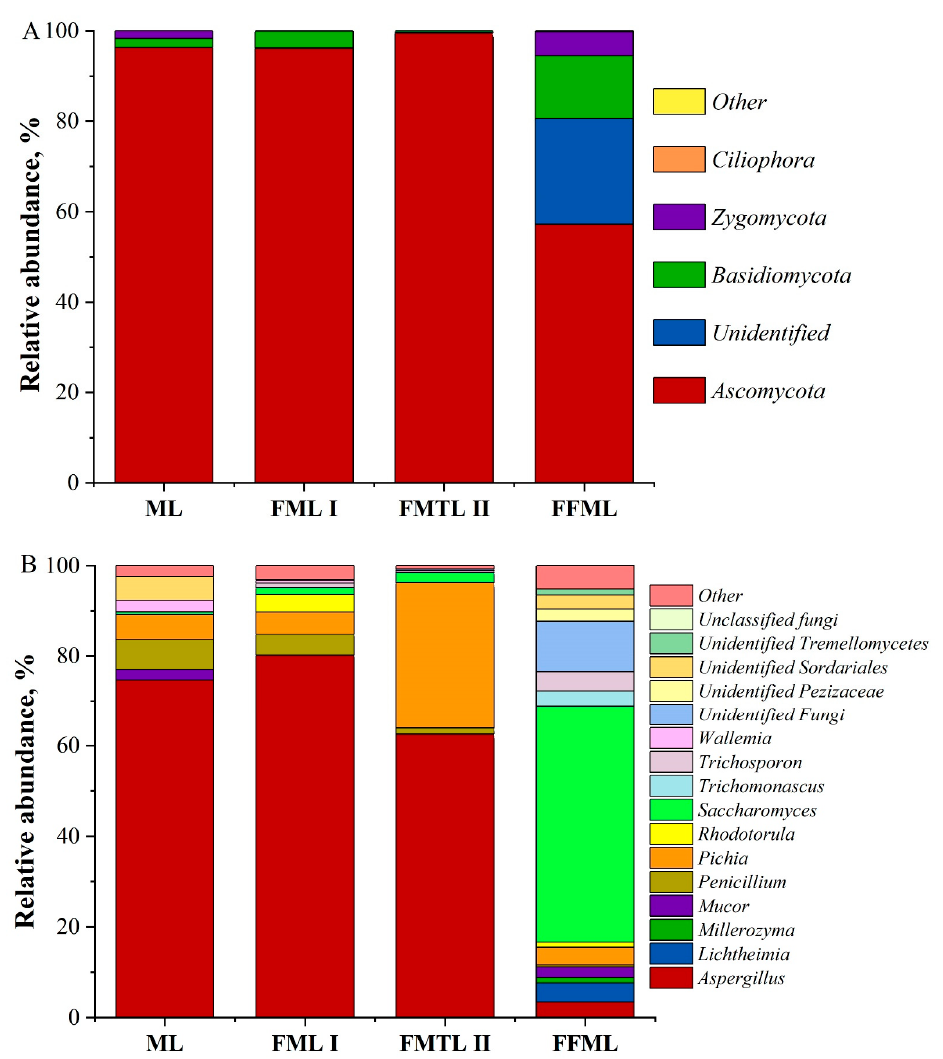
Figure 2. The fungi composition of Mao-tai lees and fermented Mao-tai lees at the phylum ( A ) and 382 genus ( B ) levels. ML, Mao-tai lees; FML, fermented Mao-tai lees; FML I, FML in the first stage; FML 383 II, FML in the second stage; FFML, FML in the final stage.